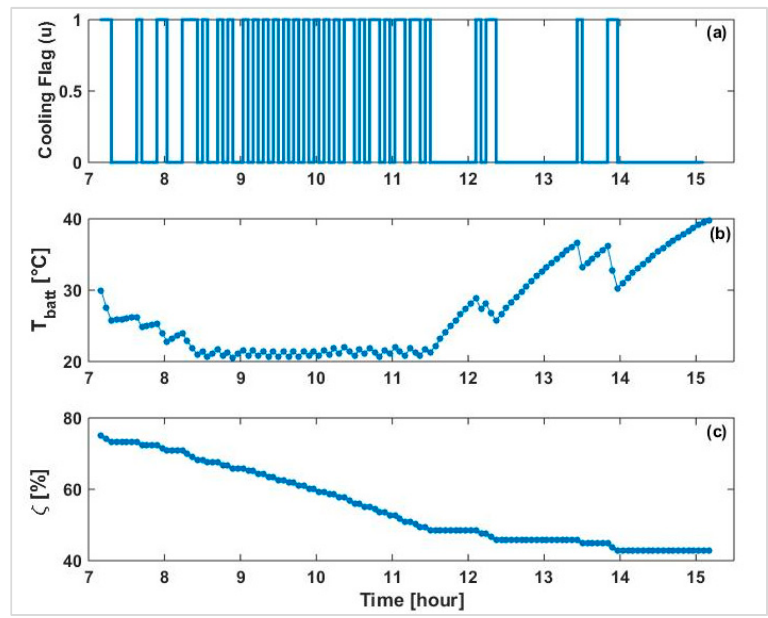
Figure 8. Optimum trajectory of ( a ) cooling flag; ( b ) battery temperature; and ( c ) SoC for key-off cooling in Day Park.